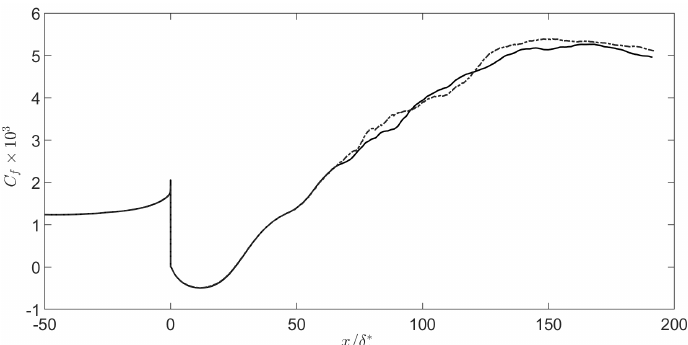
Figure 6. Skin − friction coefficient, C f , for the large-step case. 7th − order polynomials; 5th − order